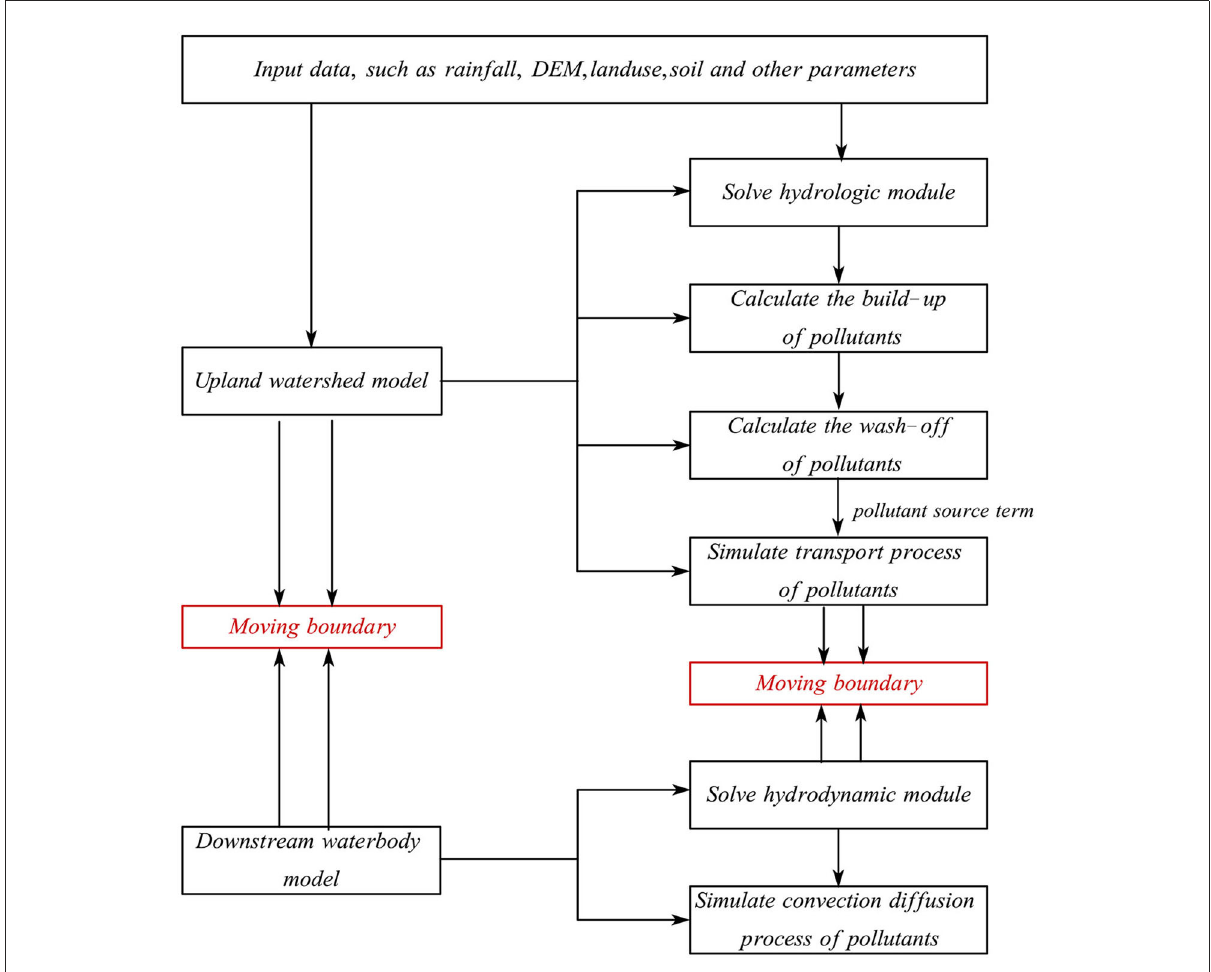
FIGURE1 E-DBCM coupling